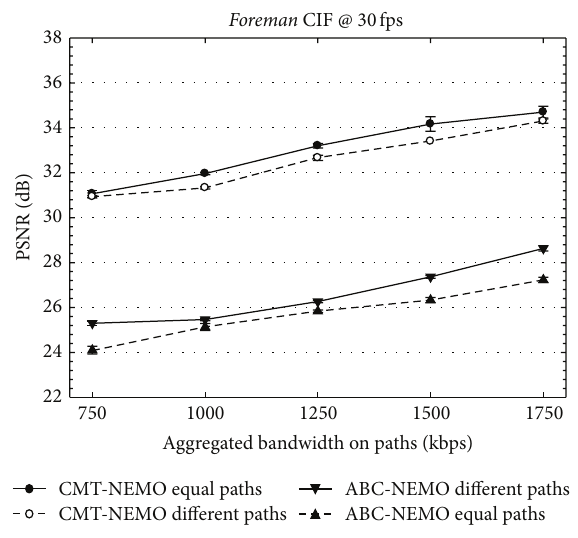
Figure 13: Comparison of schemes for the Foreman sequence at 30